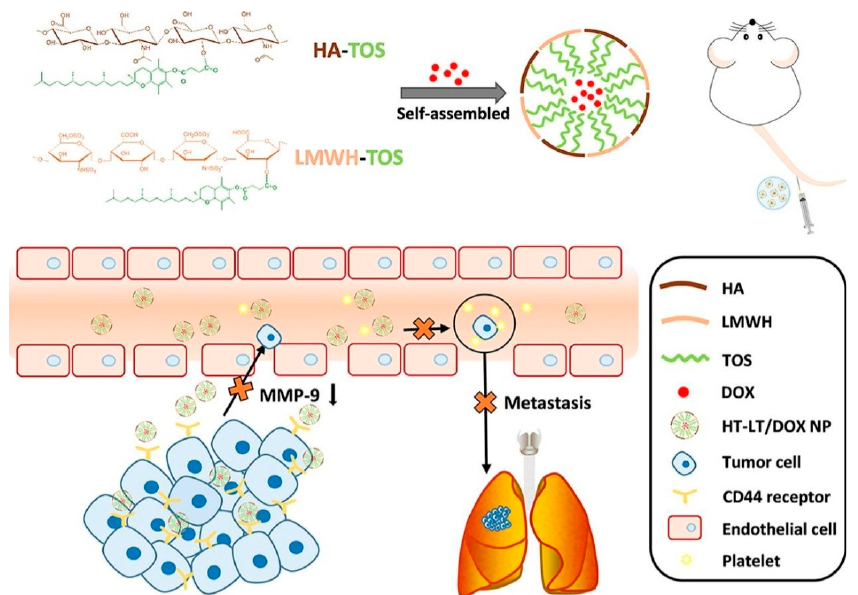
Figure 7. Schematic representation of a polymeric micelle-based drug delivery system, HA known to target CD44 receptors on TNBC cells and drug DOX loaded to inhibit metastasis of breast cancer by downregulating MMP-9 factor. Reproduced with permission from ref. [119] Copyright © 2020, Elsevier. Table 3. Recent examples of micelle-based drug delivery systems for breast cancer therapy.